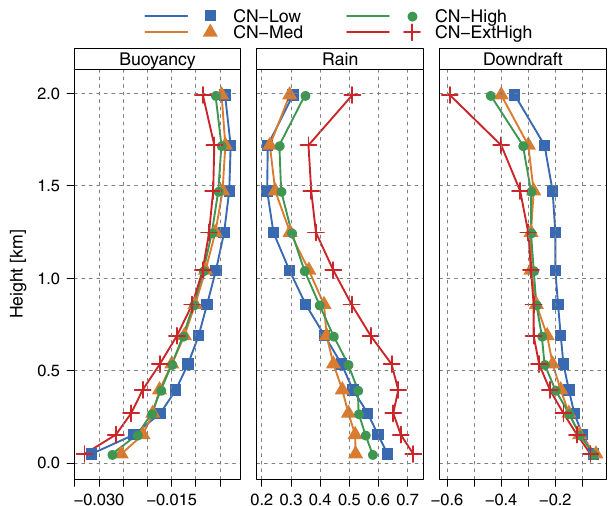
Figure 18. Averaged buoyancy, rain mixing ratio and downdraft between 09:00 and 10:00UTC for the CN-Low (blue), CN-Med (marigold), CN-High (green) and CN-ExtHigh (red) experiments. The model outputs were saved every 5min to compute these pro- files. Only vertical velocities smaller than − 1ms − 1 are considered for the